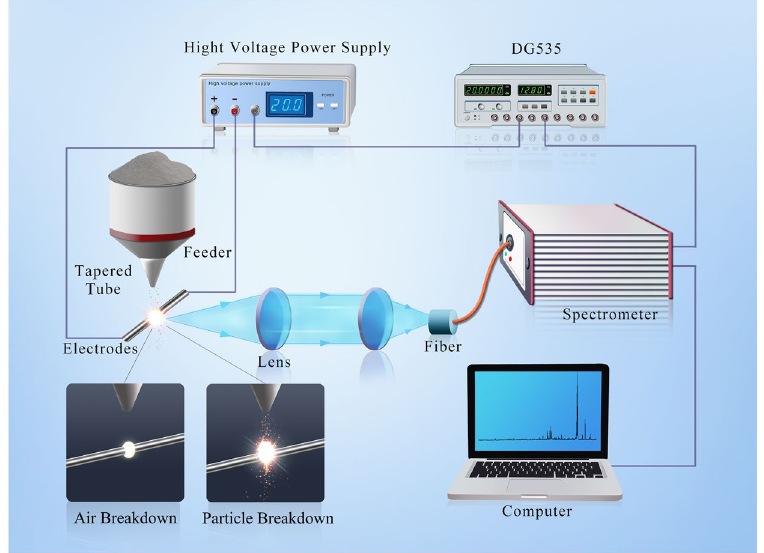
Figure 7. Schematic diagram of the PF-SIBS